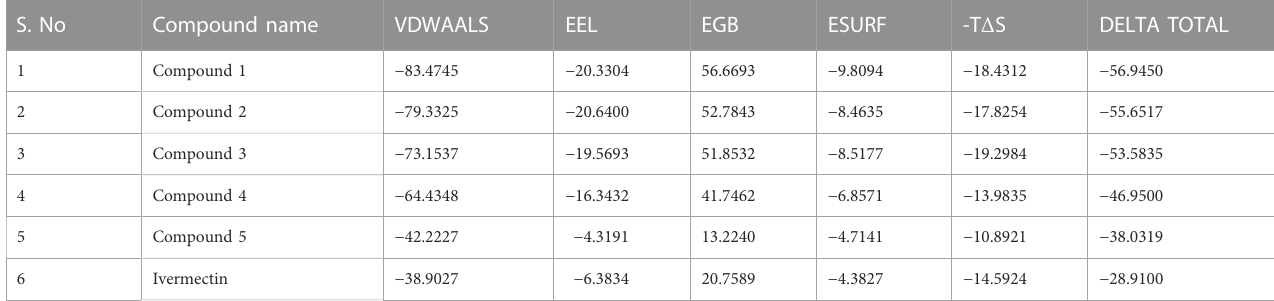
TABLE 6 Represents MMGBSA Binding Free Energy (kcal/mol) calculation for the selected phytochemicals and control compound. S.